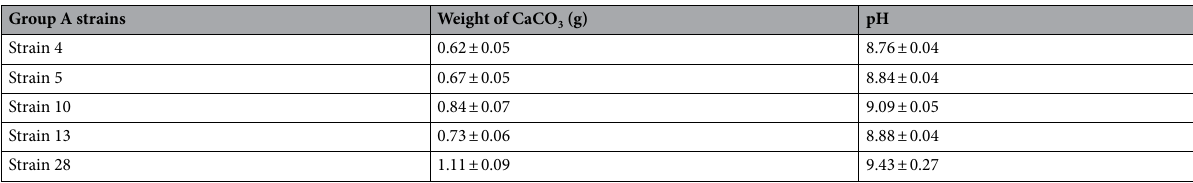
Table 2. The weights (g) and pH of carbonate precipitate.